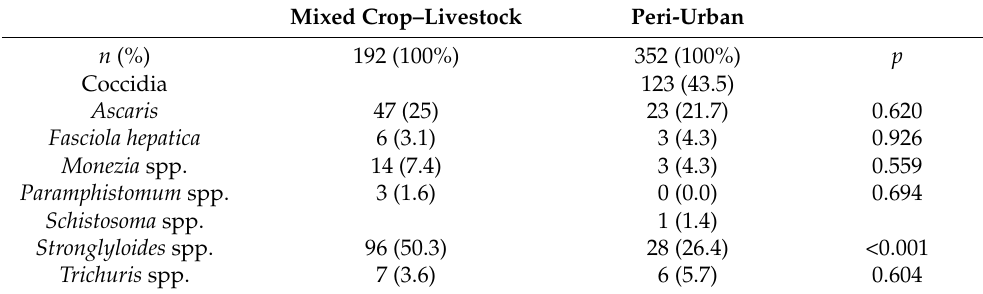
Table 7. Fecal parasite test results *.